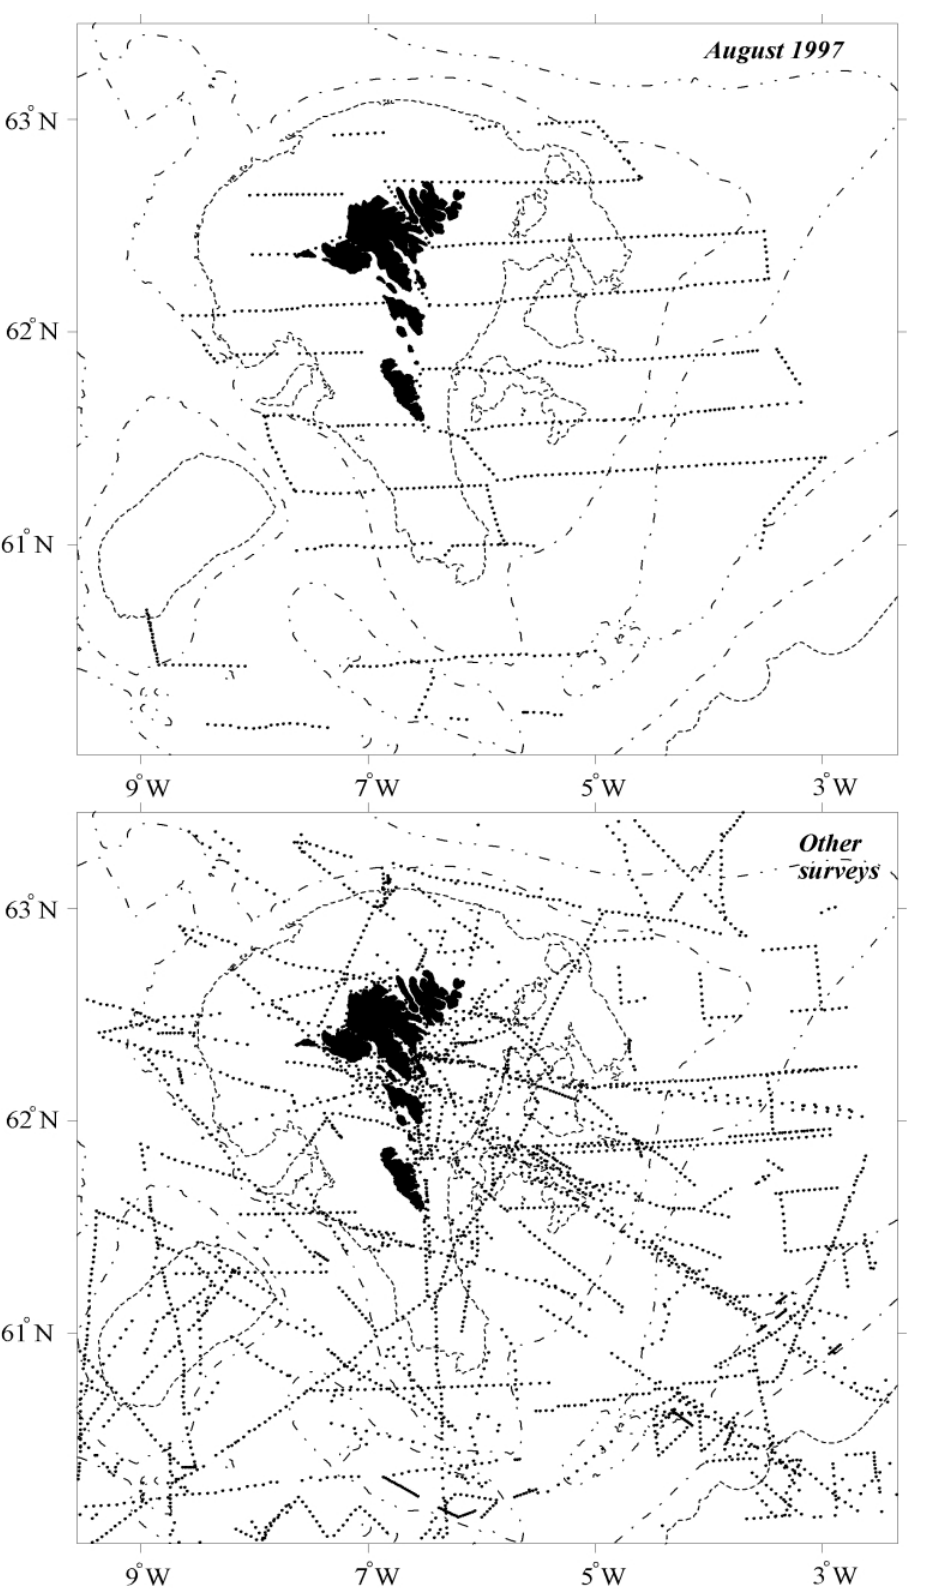
Fig. 2 . The distribution of samples (line transect segments) of the abundance of harbour porpoise in sea states 0-2 during the survey in August 1997 and during the remaining surveys done between May and September 1987-1999. The 100 m, 300 m and 1000 m depth contours are